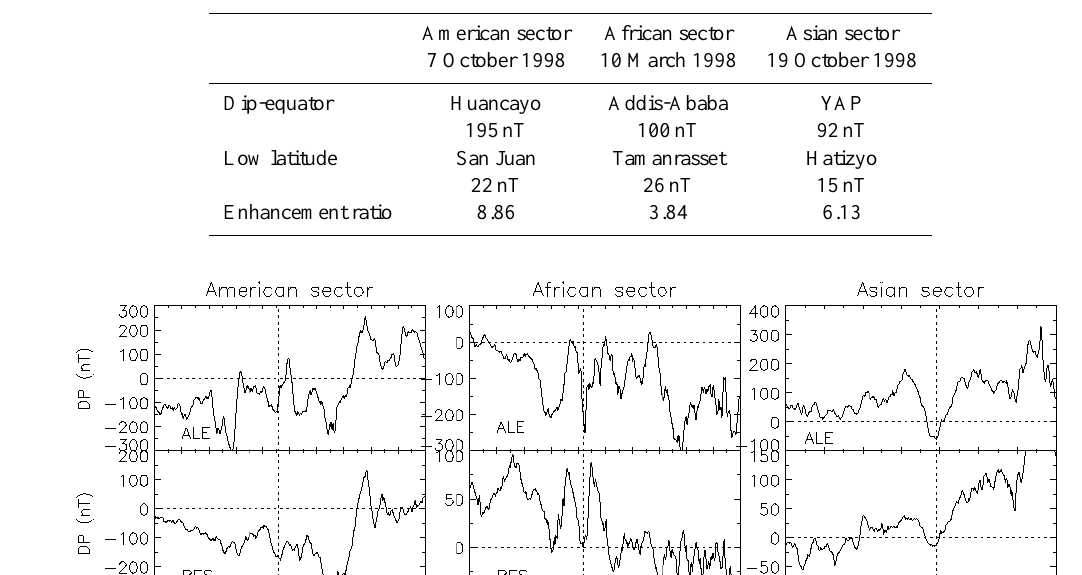
Table 4. DP2 amplitudes at low latitude and the equator and the enhancement ratio of DP2 between the dip-equator and the low latitude over the American, African and Asian longitude sectors.